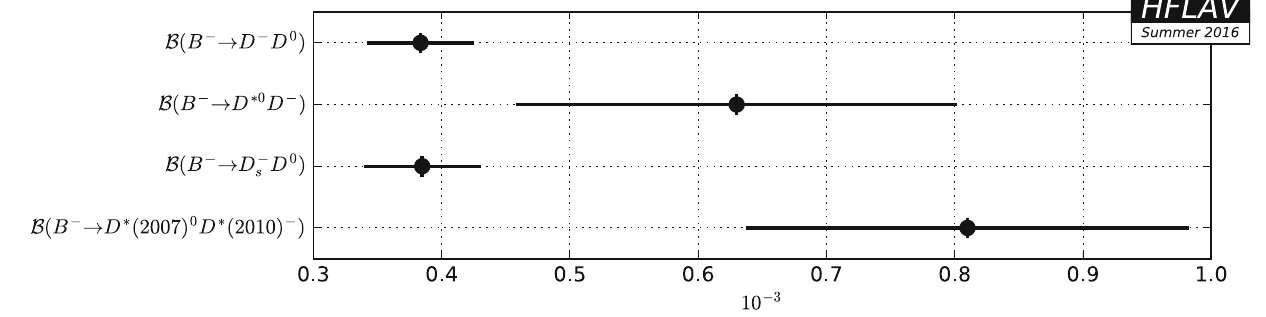
Fig. 120 Summary of the averages from Table 150